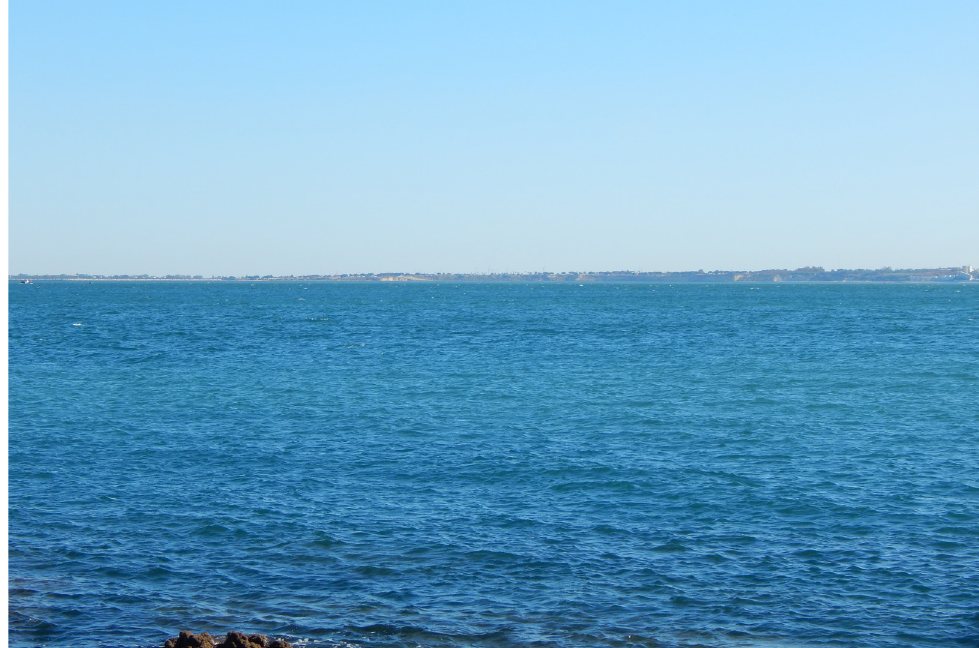
Figure 18. Visualisation of Rota from the Punta del Nao-point 2.